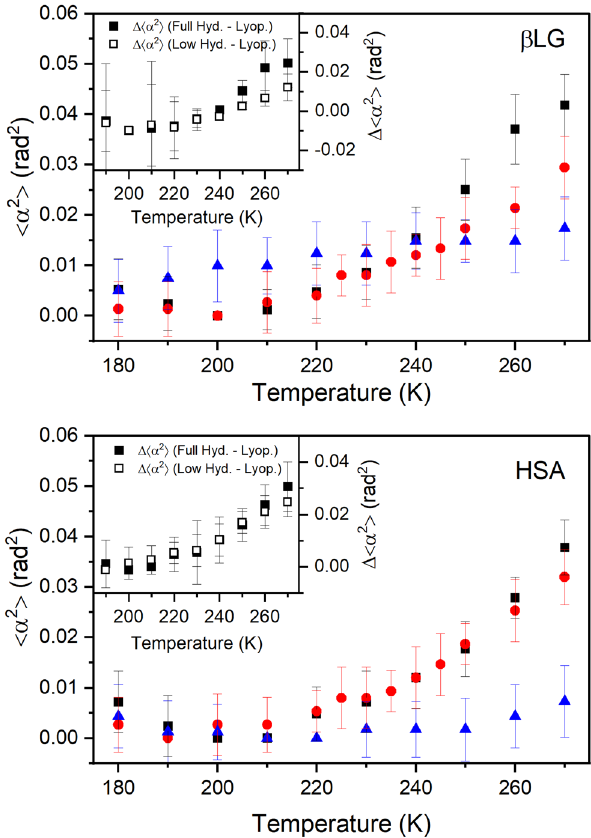
Figure 4: Temperature dependence of the mean - square librational amplitude, 〈 α 2 〉 , for β LG/5 - MSL and HSA/5 - MSL at di ff ering hydra - tion conditions: lyophilized ( triangles ) , low hydration ( circles ) , and full hydration ( squares ) . Inset: Di ff erence, Δ 〈 α 2 〉 = 〈 α 2 〉 ( hydrated ) − 〈 α 2 〉 ( lyophilized ) , between 〈 α 2 〉 values for the hydrated ( fully and low ) and lyophilized